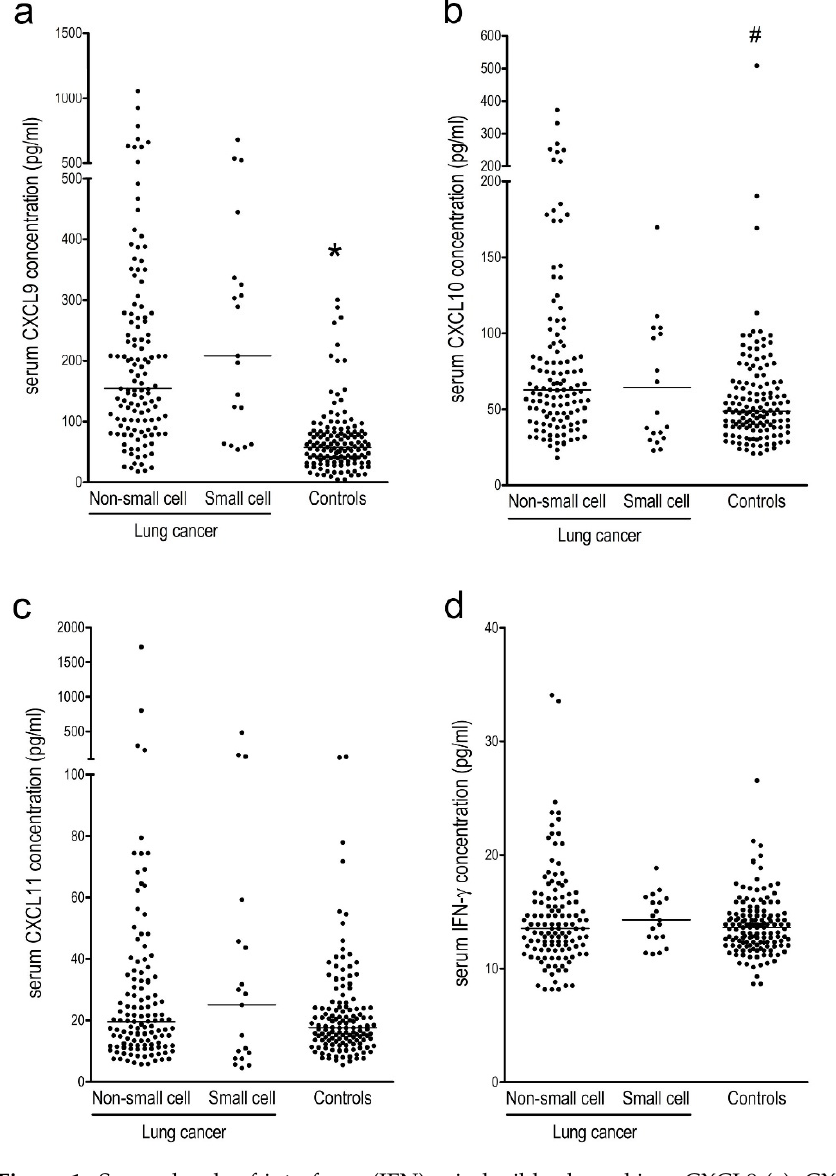
Figure 1. Serum levels of interferon (IFN)- γ -inducible chemokines CXCL9 ( a ), CXCL10 ( b ), and CXCL11 ( c ) and IFN- γ ( d ) levels in patients with lung cancer and healthy controls. Lung cancer patients are further divided into non-small cell and small cell lung cancers. * p < 0.0001 compared to both non-small cell carcinoma and small cell lung cancer. # p < 0.007 compared to non-small cell lung cancer.